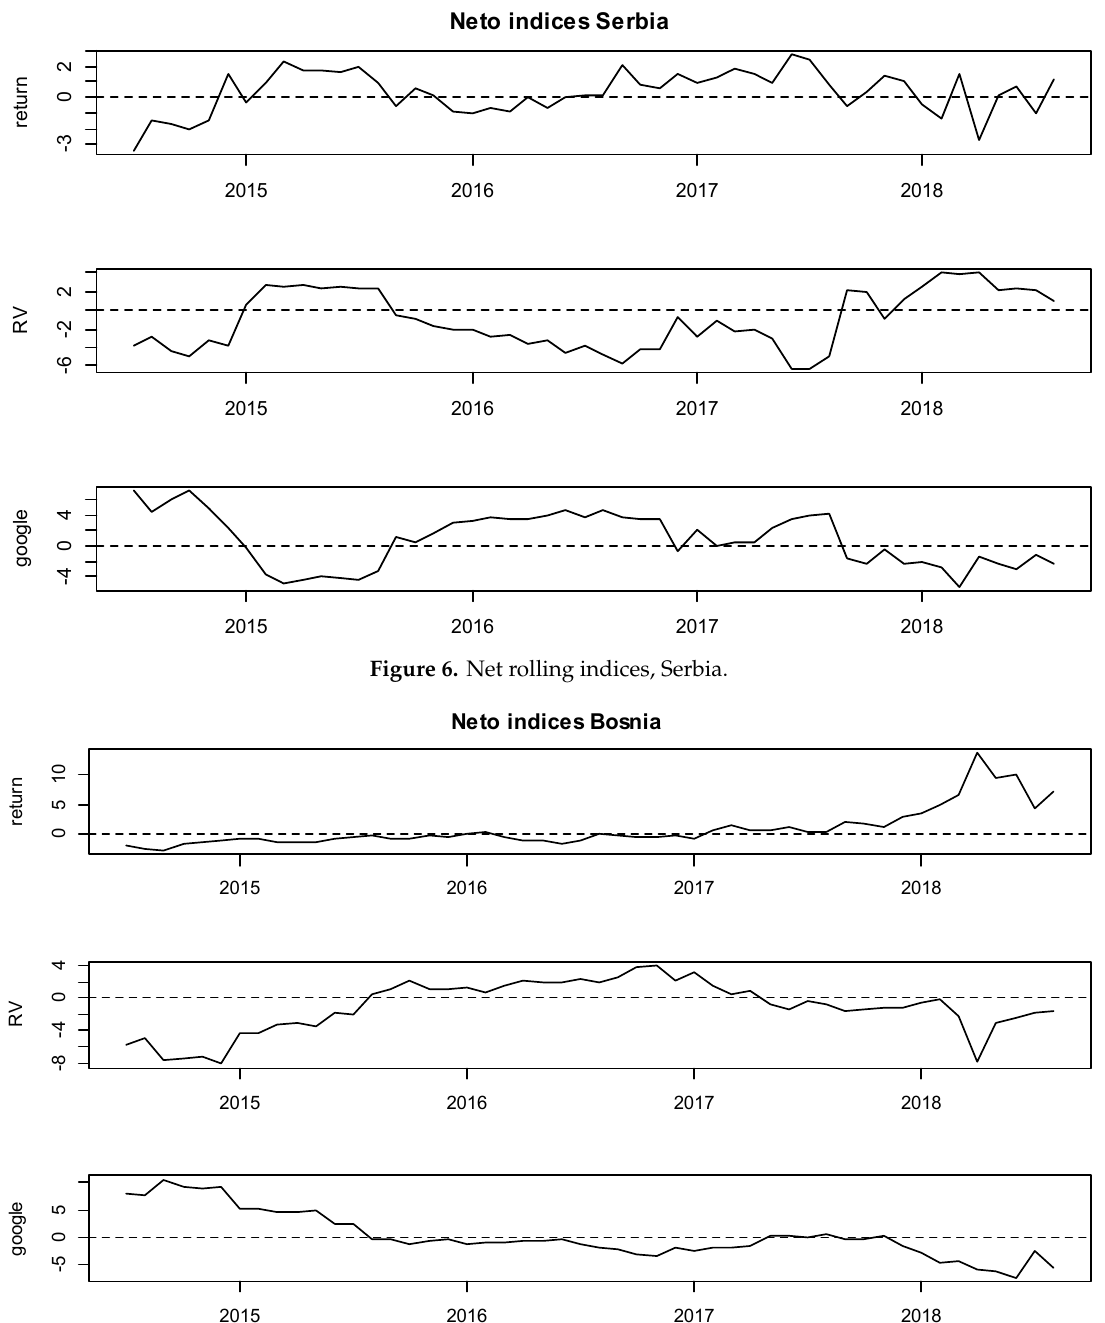
Figure 7. Net rolling indices, Bosnia and Herzegovina.